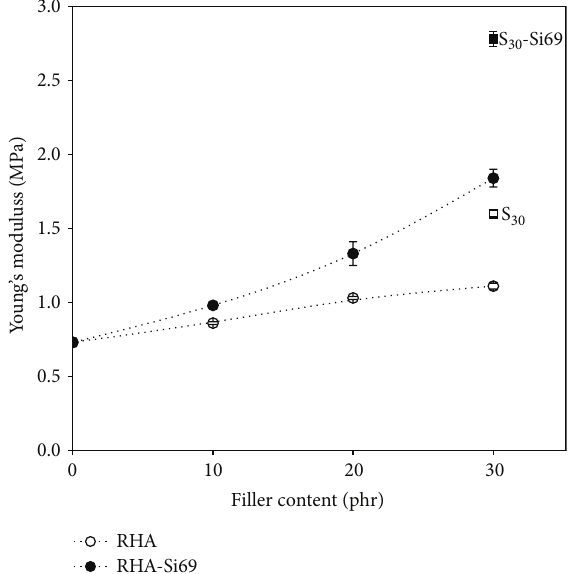
Figure 7: Tensile strength of gum and filled ENR-25 vulcanizates with various RHA contents and 30 phr of silica with and without silane coupling agent (Si69).